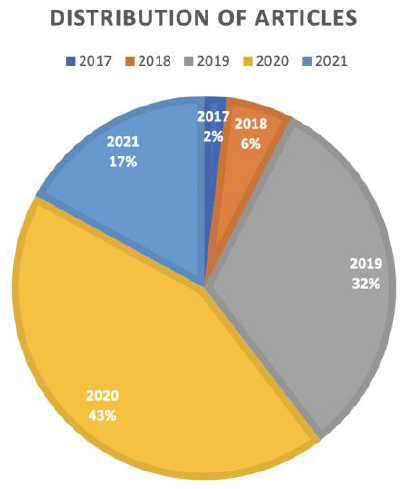
Figure 2. Distribution of Articles over the years.